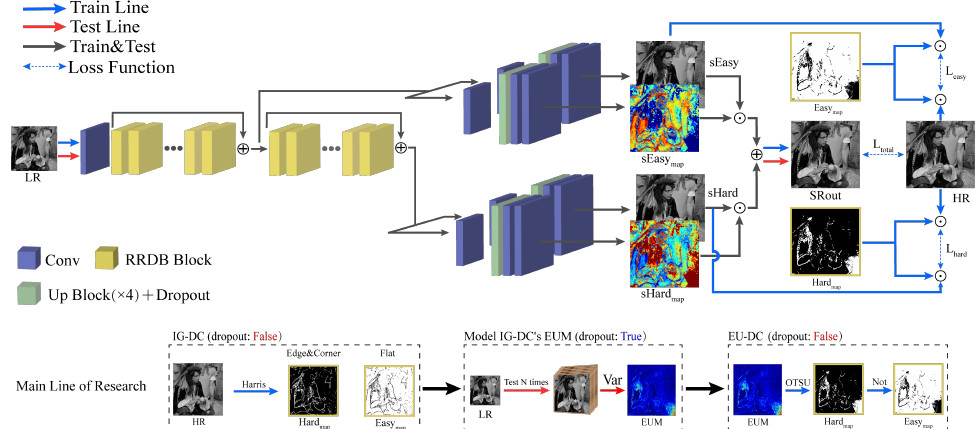
Figure 1. The overall structure of our proposed SR method. Conv denotes a 3 × 3 convolution layer. The RRDB block and up block are the same as those proposed in [10]. Up Block ( × 4 ) + Dropout denotes the sequential connection of the up block ( × 4) and dropout layer. (cid:12) and ⊕ denote element- wise multiplication and element-wise addition operations. The main line of research includes